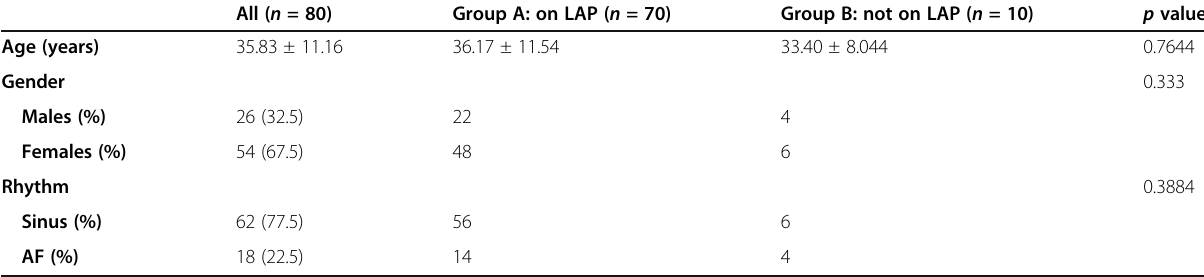
LAP long-acting penicillin, AF atrial